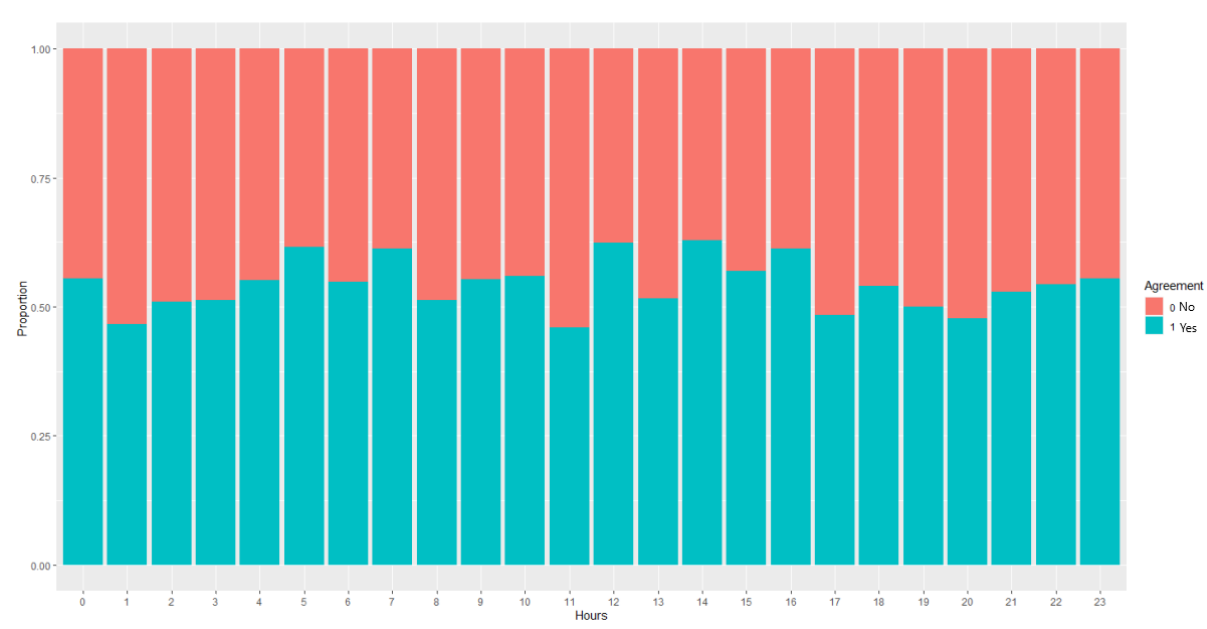
Figure 3. Activator nurse and computer agreement by the hour.